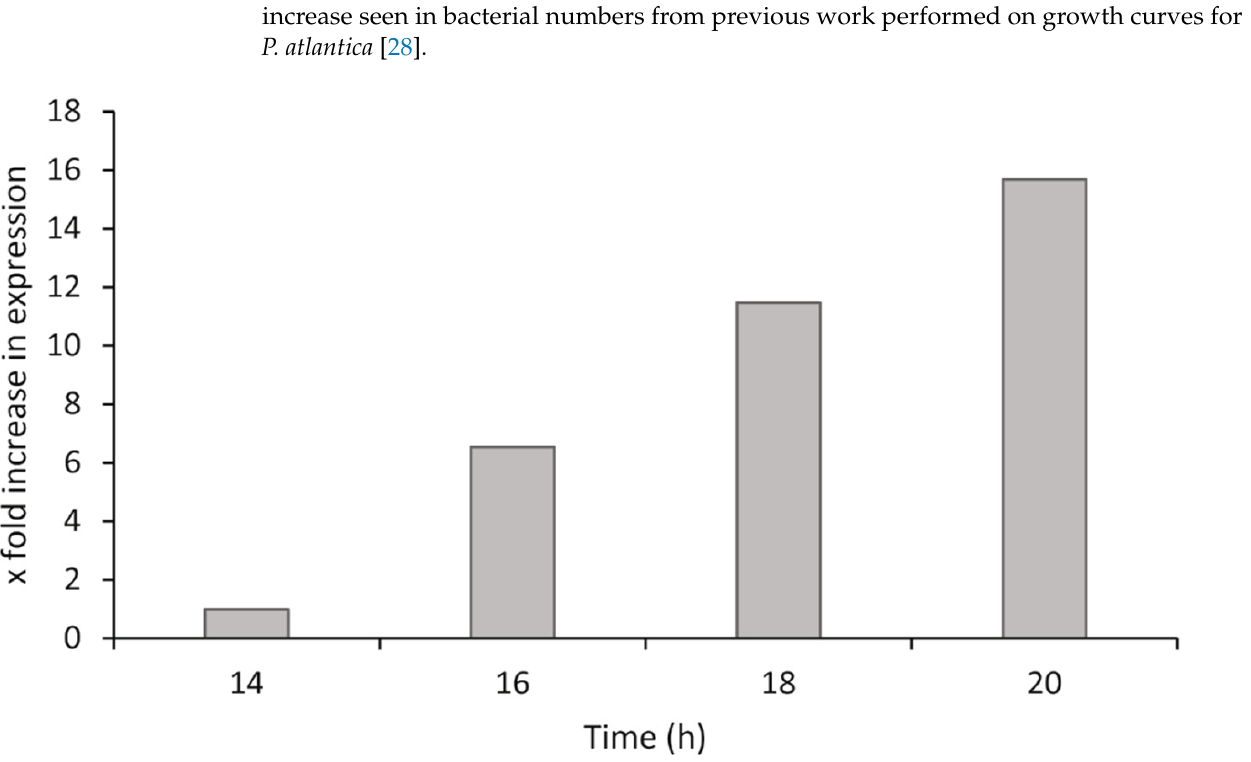
Figure 6. Fold increase in relative expression levels of < hia> in P. atlantica (UiBP1-2013) over time in the presence of lumpsucker head kidney leucocytes, compared to bacteria not exposed to HKL. Error bars represent standard deviation ( n = 4). Asterisks represent significant differences in ex- pression between the time points indicated by square brackets.